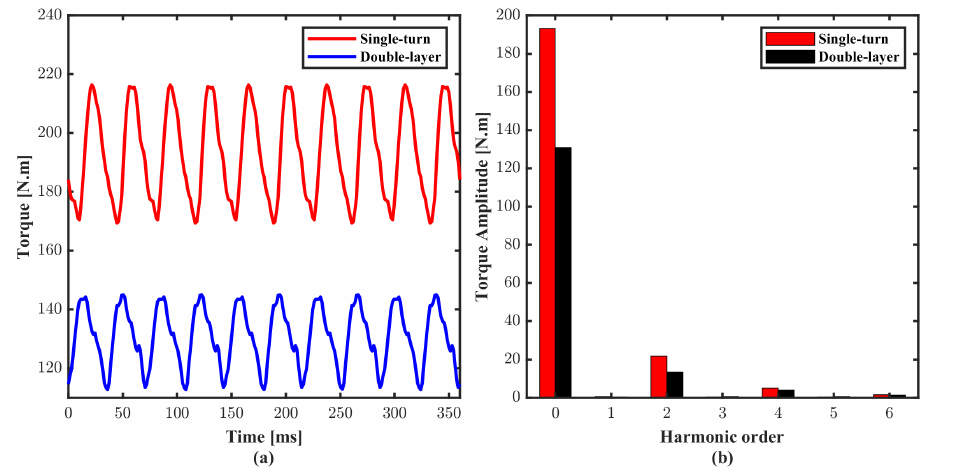
Figure 10. Torque Comparison between five-phase single-turn motor and double-layer motor. ( a ) Elec- tromagnetic Torque. ( b ) Harmonic